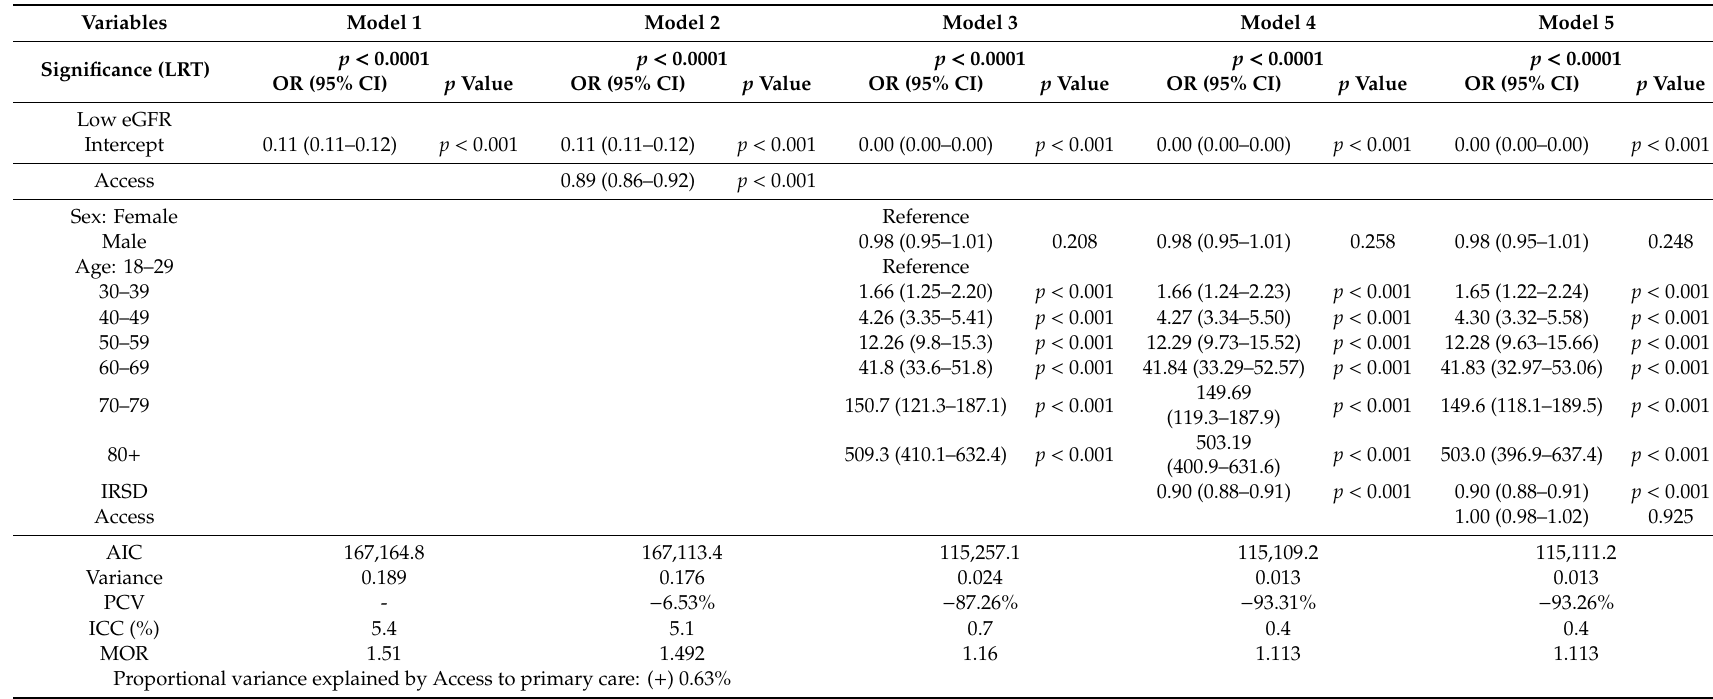
Table 8. Multilevel logistic regression model summaries of low eGFR ( < 60 mL / min / 1.73 m 2